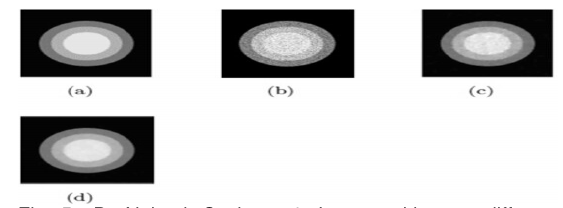
Fig 5: De-Noised Synimage2 Image with two different algorithms (a) True Image (b) Noisy Image L 2 = 0.1 (c) De-